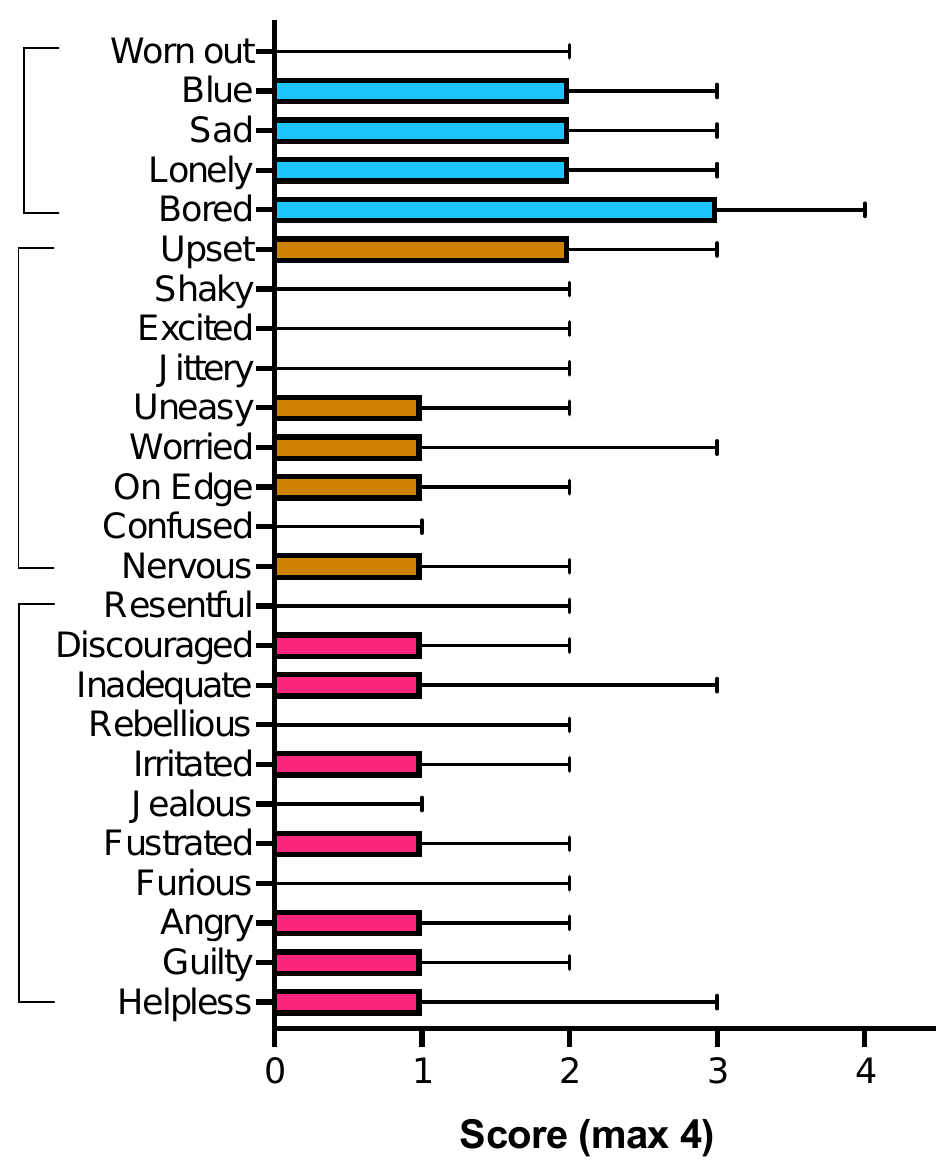
Figure 1. Median and IQR scores of individual emotions from the EES, grouped by subscale for all participants ( n = 387). Subscales are depression (blue), anxiety (orange), anger (pink).